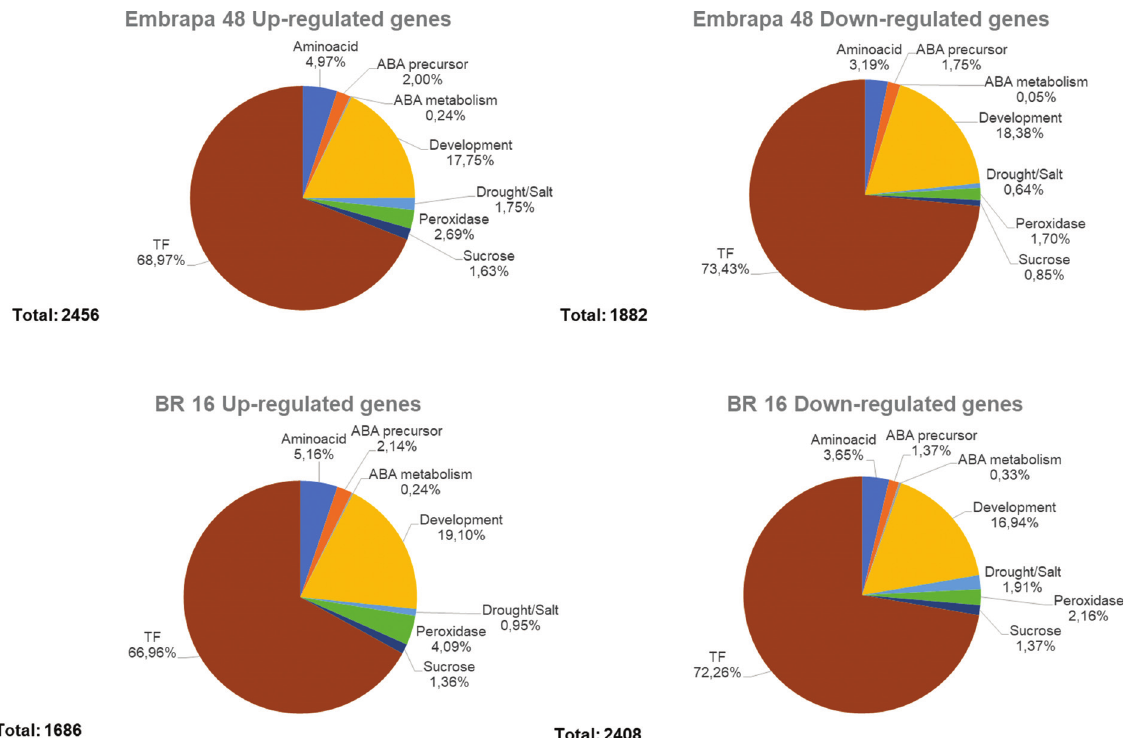
Figure 4 - Graphic representation of eight gene categories (enriched biological process from MapMan 3.6 ORC), analyzed in up- and down-regulated gene groups from the cultivars BR 16 and Embrapa 48.